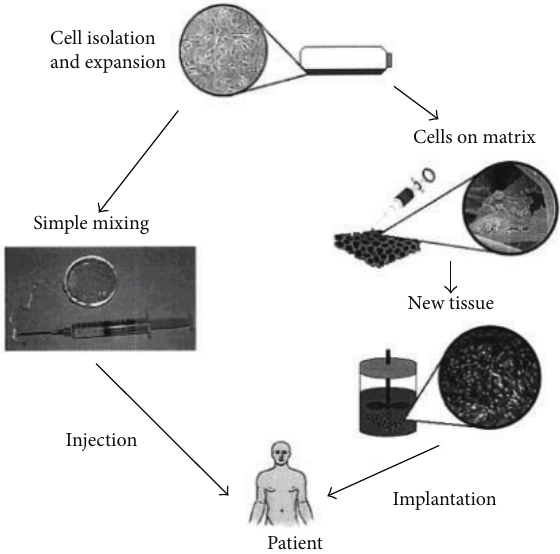
Figure 2: Schematic illustration of two approaches to engineer desired tissue. Cellsareisolated frombiopsy and mixed with scaffold materials. Subsequently the mixture system is injected into patients’ body (left). Alternatively, isolated cells are cultured on a scaffold in vitro and implanted into desired place after the formation of new functional tissue (right). Reprinted (adapted) with permission from [42]. Copyright (2001) American Chemical